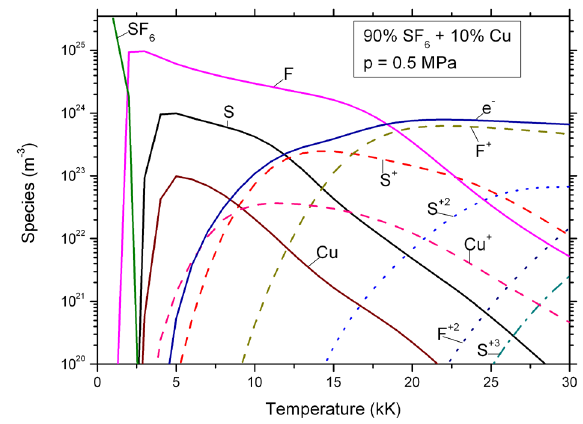
+ 10% Cu plasma as a function of 6